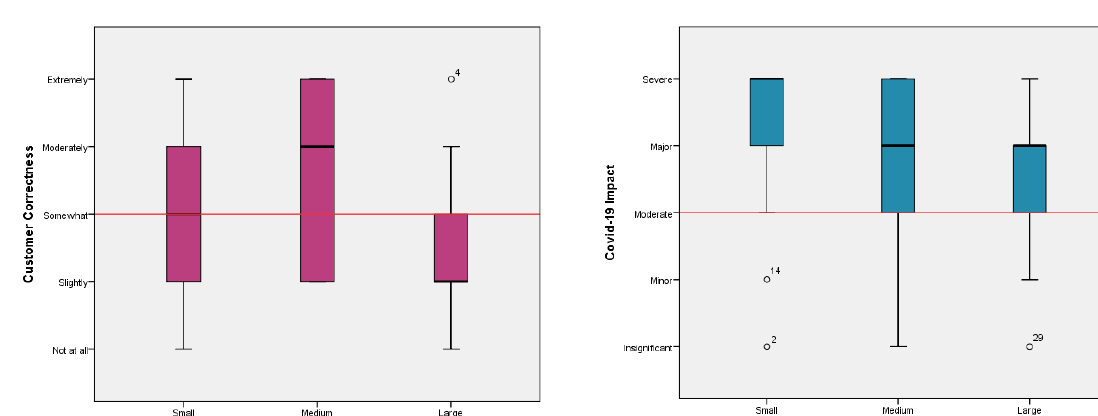
Figure 3. Rental payment capacity Figure 4. Cash reserves usage